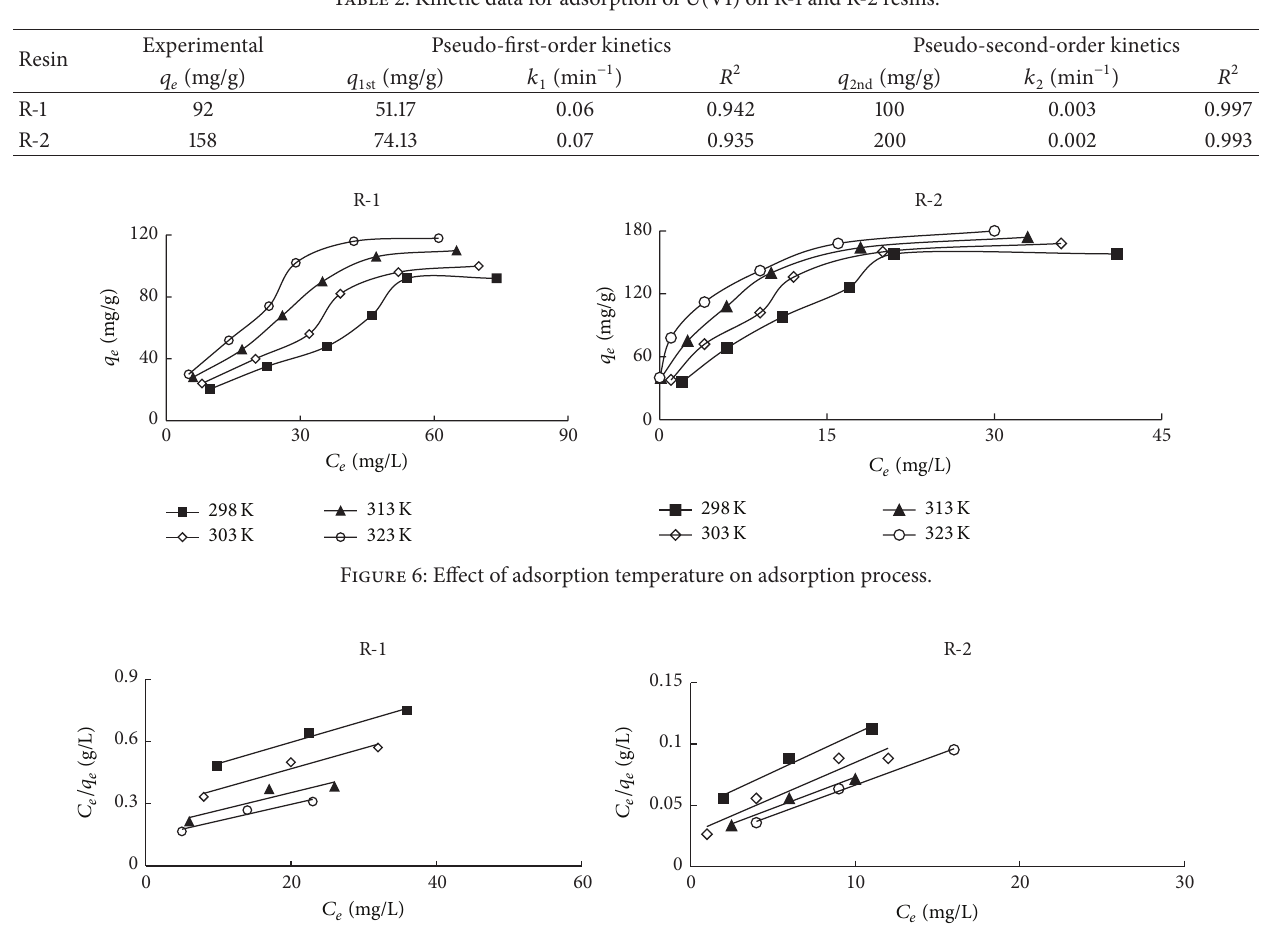
Table 2: Kinetic data for adsorption of U(VI) on R-1 and R-2 resins.